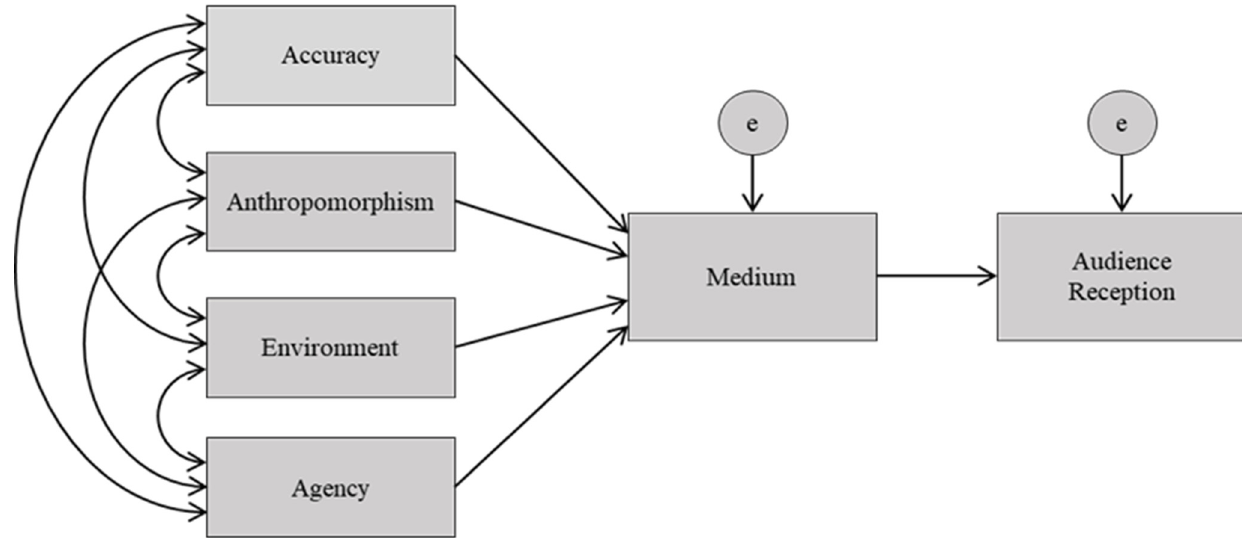
Figure 1. SEM Theoretical Model. Each line indicates a parameter set on the model. Double-headed arrows represent a covariance. Single-headed arrows represent direct effects. Rectangles are the observed variables. Circles are unobserved, latent variables where ‘e’ is the residual error.